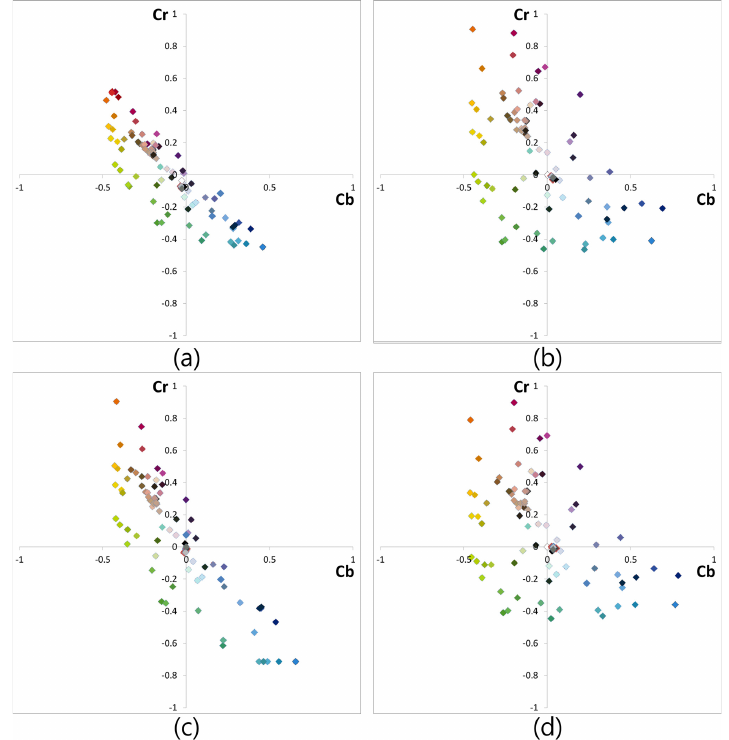
Figure 12. Color distribution of 96 color patches of the GretagMacbeth ColorChecker SG: ( a ) RWB image before RGB color conversion; ( b ) RGB color image; ( c ) 3 × 3 CCM; and ( d ) Proposed